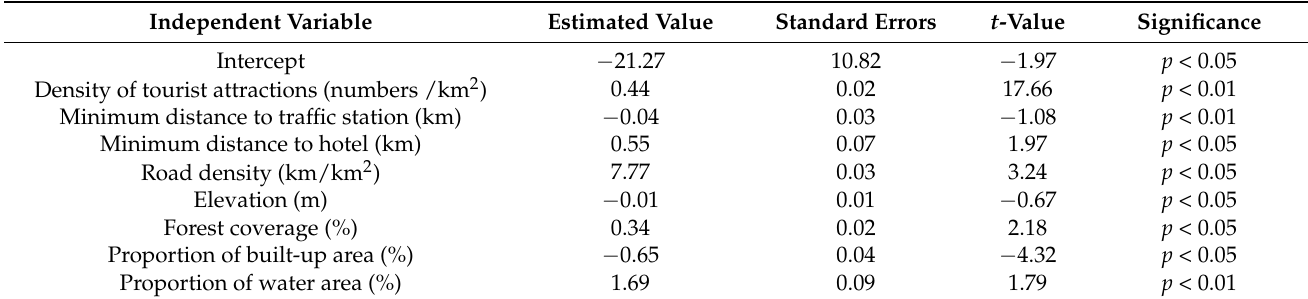
Table 2. Results of estimated parameters of multiple regression